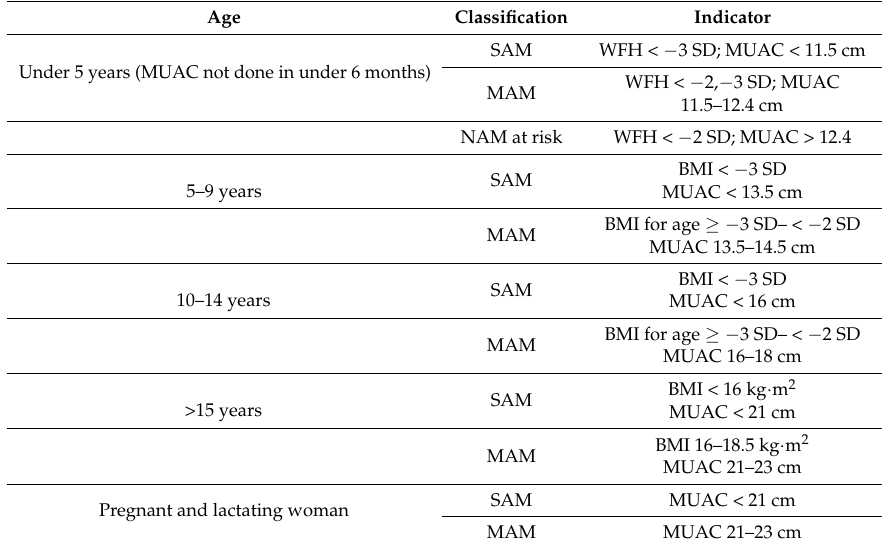
Table 2. Classification of malnutrition using anthropometric indicators